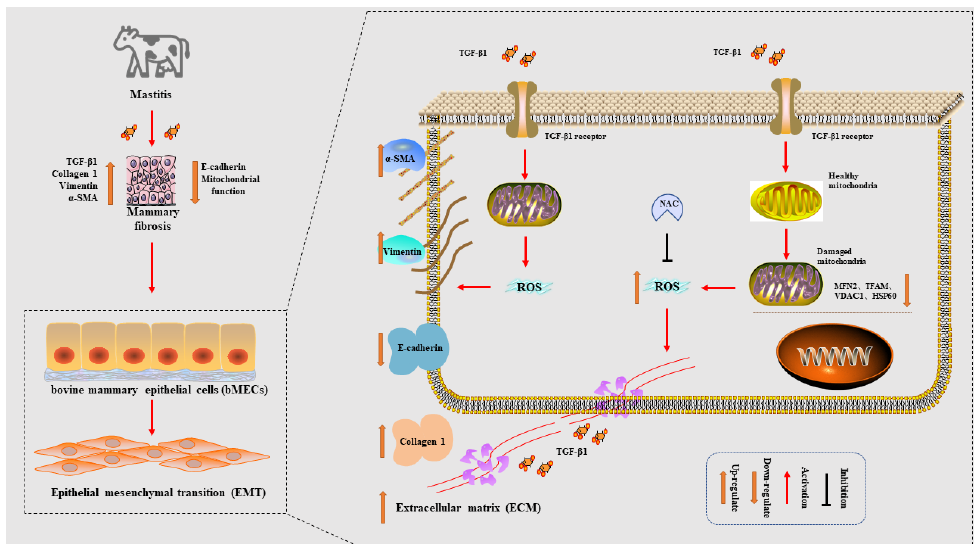
Figure 8. Schematic diagram of the experimental mechanism. The fibrotic phenotype of mammary gland tissue was significantly elevated in cows with mastitis, and mastitis disease was positively correlated with mammary fibrotic lesions. In an in vitro and in vivo model of cow mammary fibrosis, bMECs have impaired mitochondrial structure and dysfunction. Inhibiting the accumulation of ROS effectively alleviates the elevated fibrotic phenotype, which may be a potential therapeutic approach to alleviate mammary fibrosis.